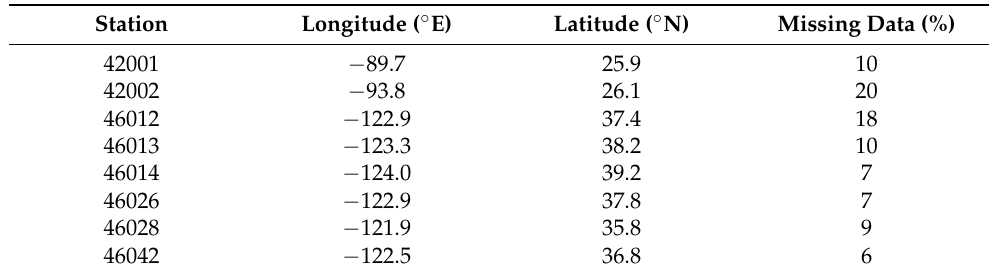
Figure 5. ( a ) Time series of annual average SWH measured by eight buoy stations. ( b ) Histogram of annual number of wave data at each station. annual number of wave data at each station. Table 2. Information on the data of buoys located near USA-Northeast and the Gulf of